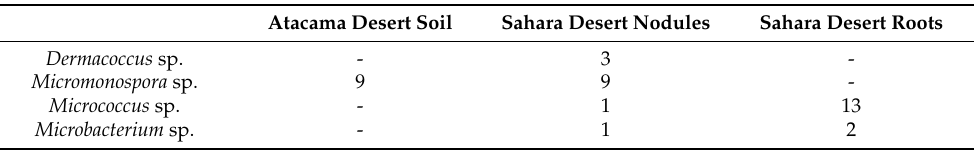
Table 1. Classification of the isolates obtained in the study, grouped by genera depending on the origin of the